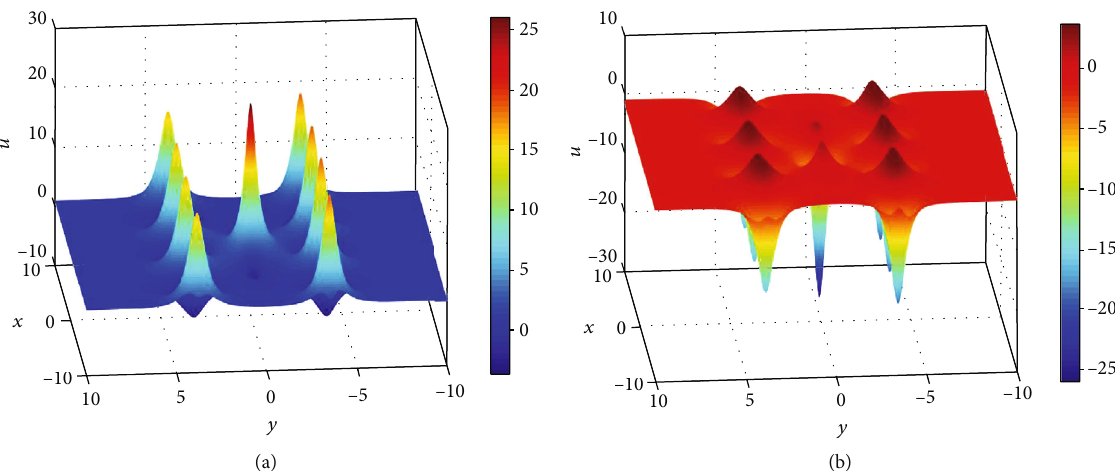
Figure 7: Two types of interactions between a lump and two breathers in Equation (1) at t = 0 . (a) Bright-type interaction solution with u 0 = 1 and c = − 1 . (b) Dark-type interaction solution with u 0 = − 1 and c = 1 .